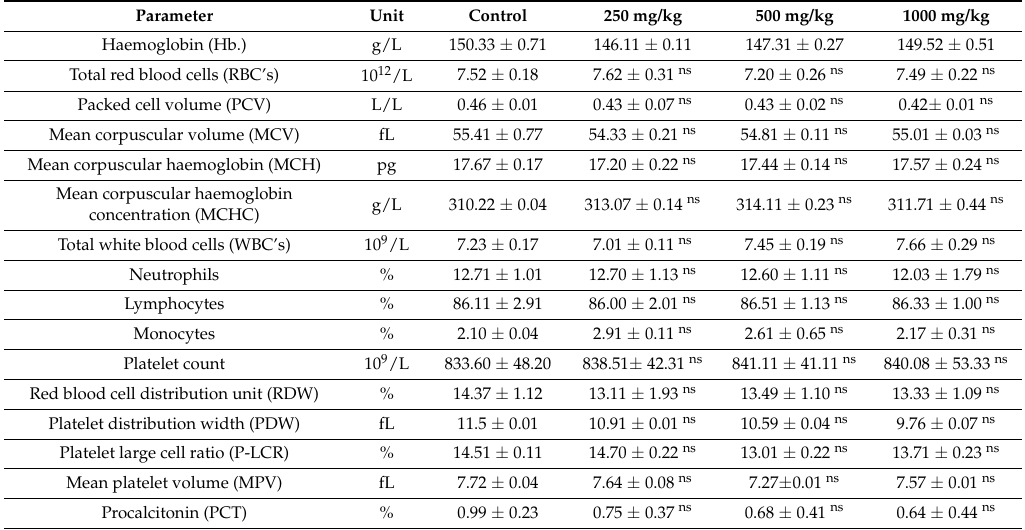
Table 6. Effect of MTE on haematological parameters in the subacute oral toxicity study.